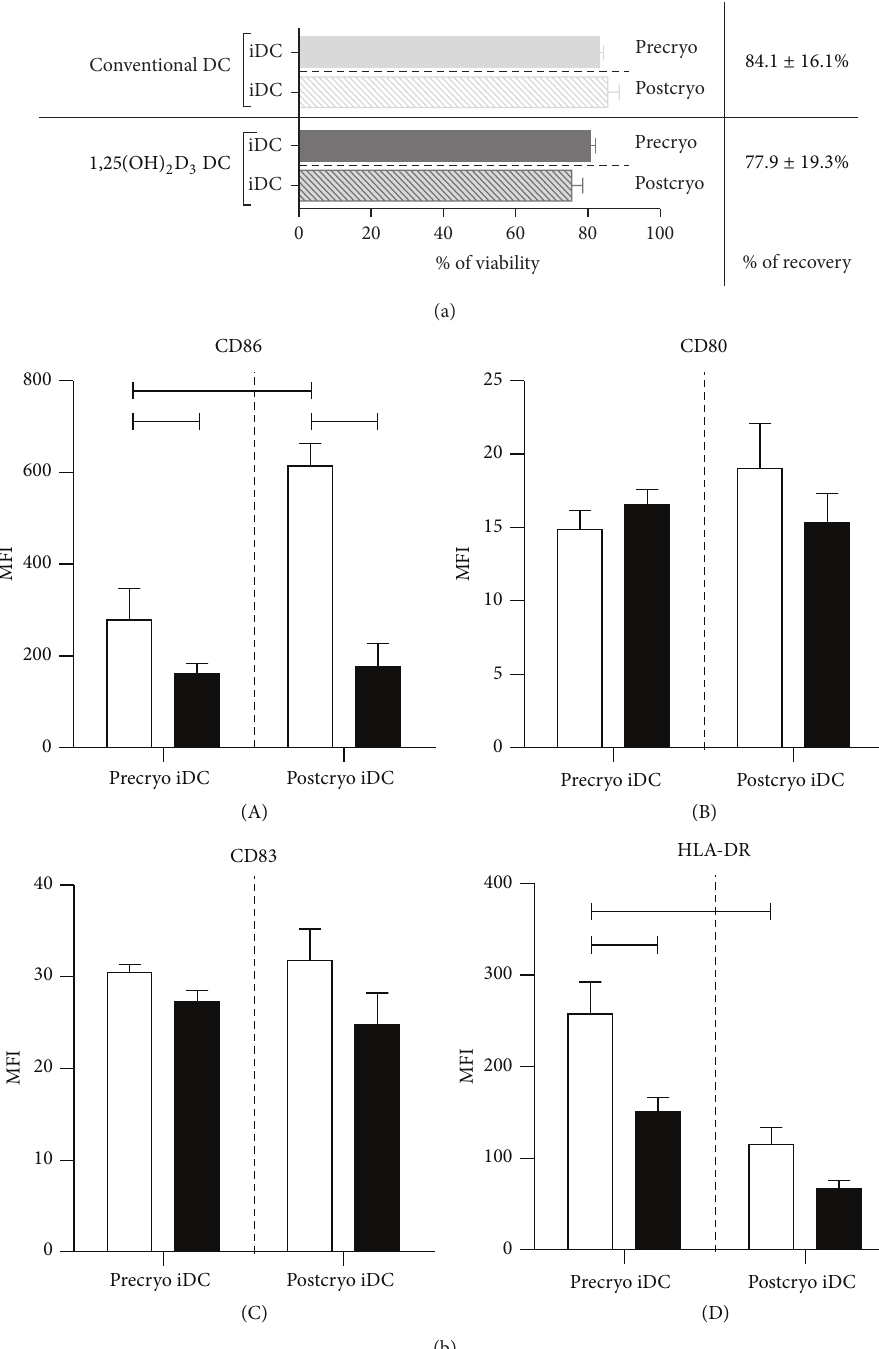
Figure 4: Viability, recovery, and phenotypic characteristics of conventional and 1,25(OH) 2 D 3 -treated iDC from healthy controls before and after cryopreservation. CD14+ monocytes were cultured for 7 days in the presence of IL-4 and GM-CSF or in the presence of IL-4, GM-CSF, and 1,25(OH) 2 D 3 to obtain immature conventional DC or 1,25(OH) 2 D 3 -treated DC, respectively. On day 7, iDC were frozen (i.e., precryo iDC). Following a 2 h resting phase after thawing, iDC were left untreated for 24 h (i.e., postcryo iDC). (a) Viability of conventional and 1,25(OH) 2 D 3 -treated iDC of healthy controls ( 𝑛 = 5 ) was determined on day 7 of DC culture (i.e., precryo) and 26 h after thawing (i.e., postcryo). Recovery is expressed as the ratio of cells harvested before and after cryopreservation. (b) The MFI of (A) CD86, (B) CD80, (C) CD83, and (D) HLA-DR by immature conventional DC (open bars) or 1,25(OH) 2 D 3 -treated DC (black bars) of healthy controls ( 𝑛 = 5 ) was determined. Results are expressed as mean ± SEM. MFI, mean fluorescence intensity, and iDC, immature